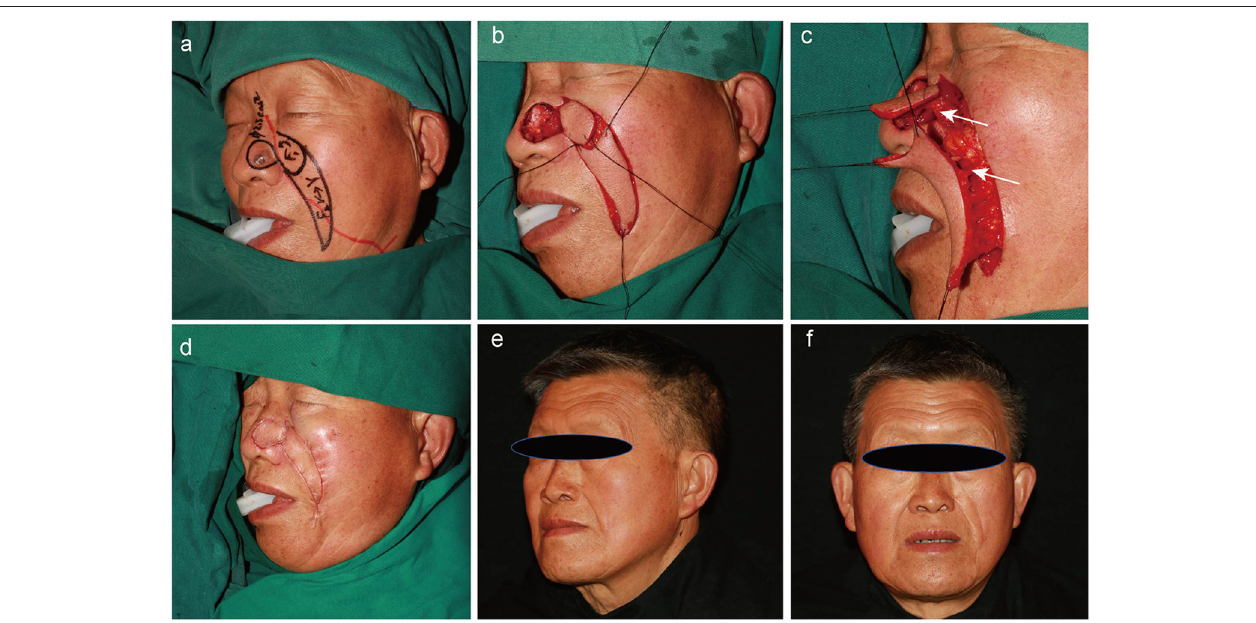
FIGURE 2 | A 69-year-old man with a history of basal cell carcinoma on the left ala for 2 years. Different steps of the operation and postoperative follow-up (25 months). (a) Preoperative design. The red line shows the location of the facial artery. (b,c) Dissection of the round rotational flap and V–Y advancement island pedicle flap. The white arrow indicates the perforating branch of the facial artery. (d) Flaps are sutured into the defect using a dermal suture with 5–0 absorbable sutures. (e,f) Appearance at 25 months after the operation.